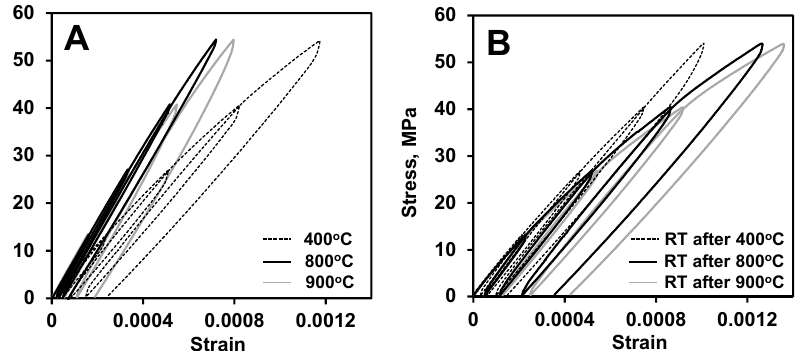
Figure 4. A comparison of stress–strain plots of LaCoO 3 sample #2 tested ( A ) at elevated and ( B ) at room temperature. LaCoO 3 sample tested at 900 °C ( A ) experienced the previous loading at 800 °C and RT, at 800 °C ( A ) experienced the previous loading at 800 °C, RT, 900 °C, and RT, and at 400 °C ( A ) experienced the previous loading at 800 °C, RT, 900 °C, RT, 800 °C, and RT. The same LaCoO 3 sample tested at RT ( B ) experienced the 800 °C and RT previous loading when tested at RT after 900 °C; 800 °C, RT, 900 °C, and RT previous loading when tested at RT after 800 °C; and 800 °C, RT, 900 °C, RT, 800 °C and RT previous loading when tested at RT after 400 °C.